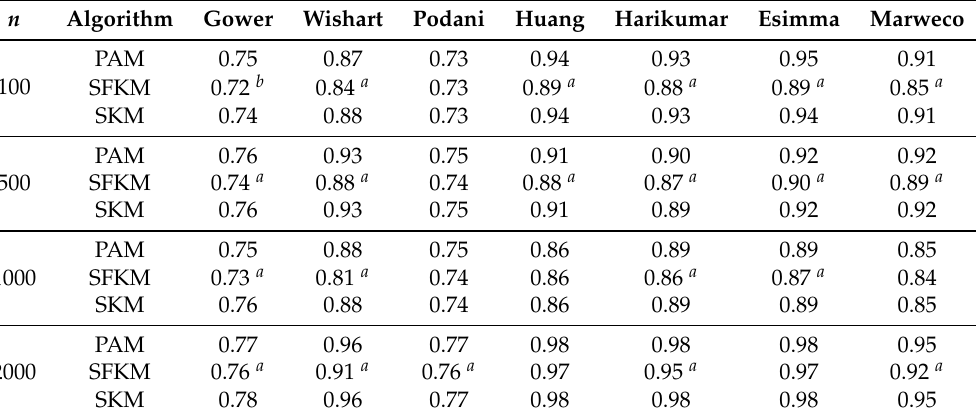
Table 7. Rand indices of the different numbers of objects.